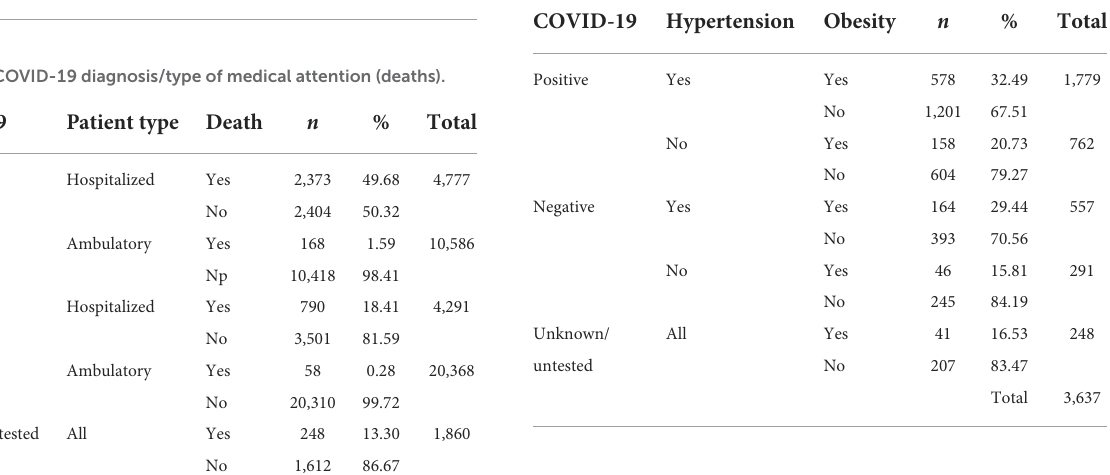
TABLE 3B Death related to COVID-19